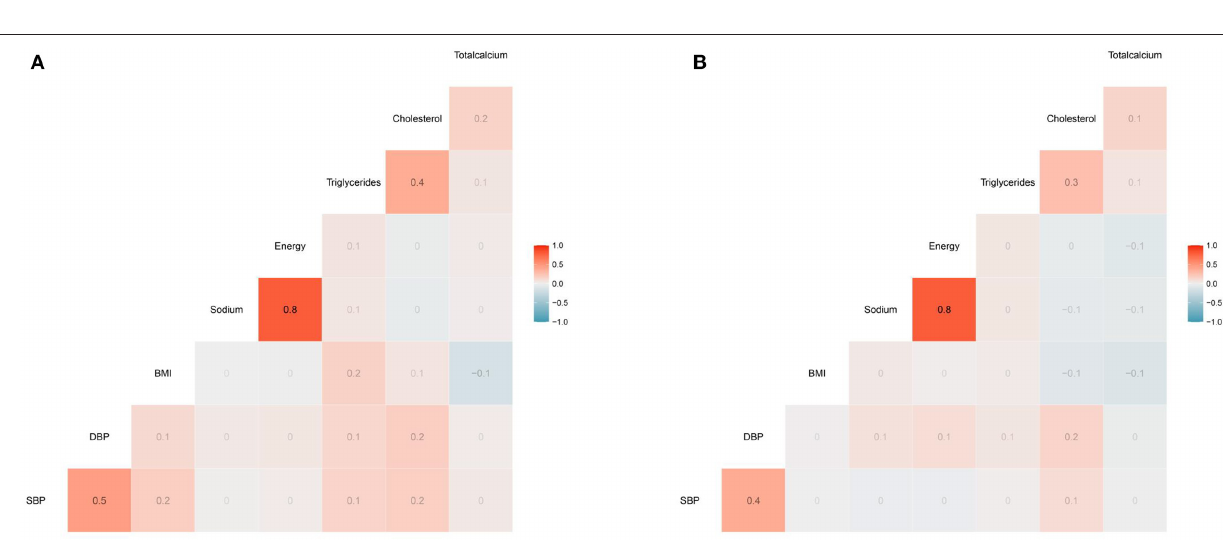
FIGURE 2 | The heatmap of the correlation between covariates and SBP/DBP using the Spearman correlation analysis among participants (A) with anti-hypertensive medications (B) without anti-hypertensive medications. No direct correlation was found between total calcium and systolic pressure/diastolic pressure both in participants with and without anti-hypertensive medications. SBP, systolic blood pressure; DBP, diastolic blood pressure; BMI, body mass